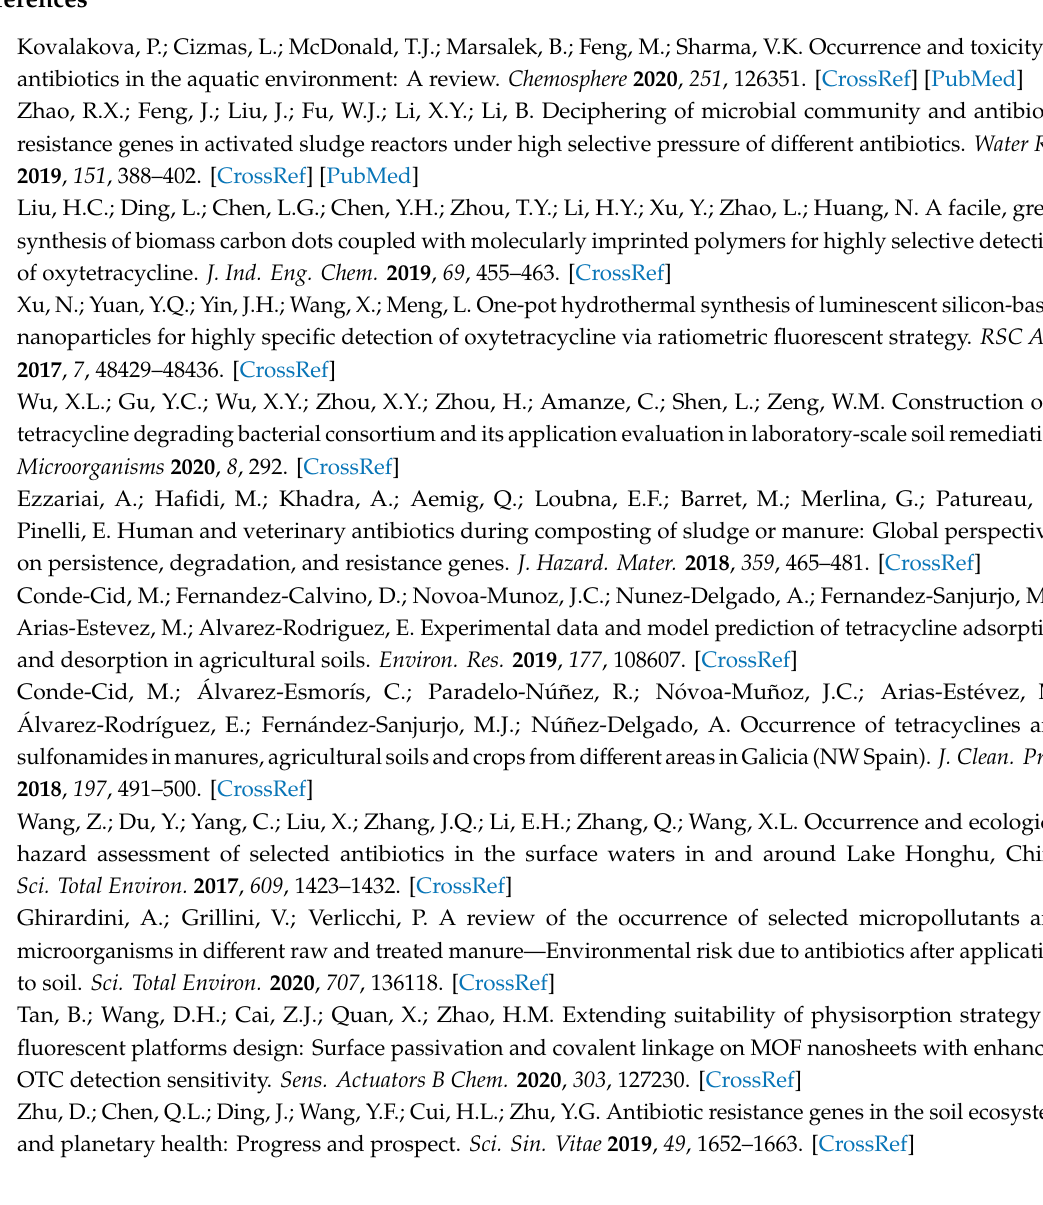
(red) at di ff erent reaction times, Figure S6: Selectivity of N-CQDs: (a) ON-CQDs; (b): WN-CQDs. Concentrations of various substances: (a), (b) correspond to 40 µ mol L − 1 and 80 µ mol L − 1 respectively. (I (cid:48) and I (cid:48) 0 represent the fluorescence intensity of N-CQDs in the presence and absence of various substances, respectively). Table S1: Compare OTC recovery rates in various